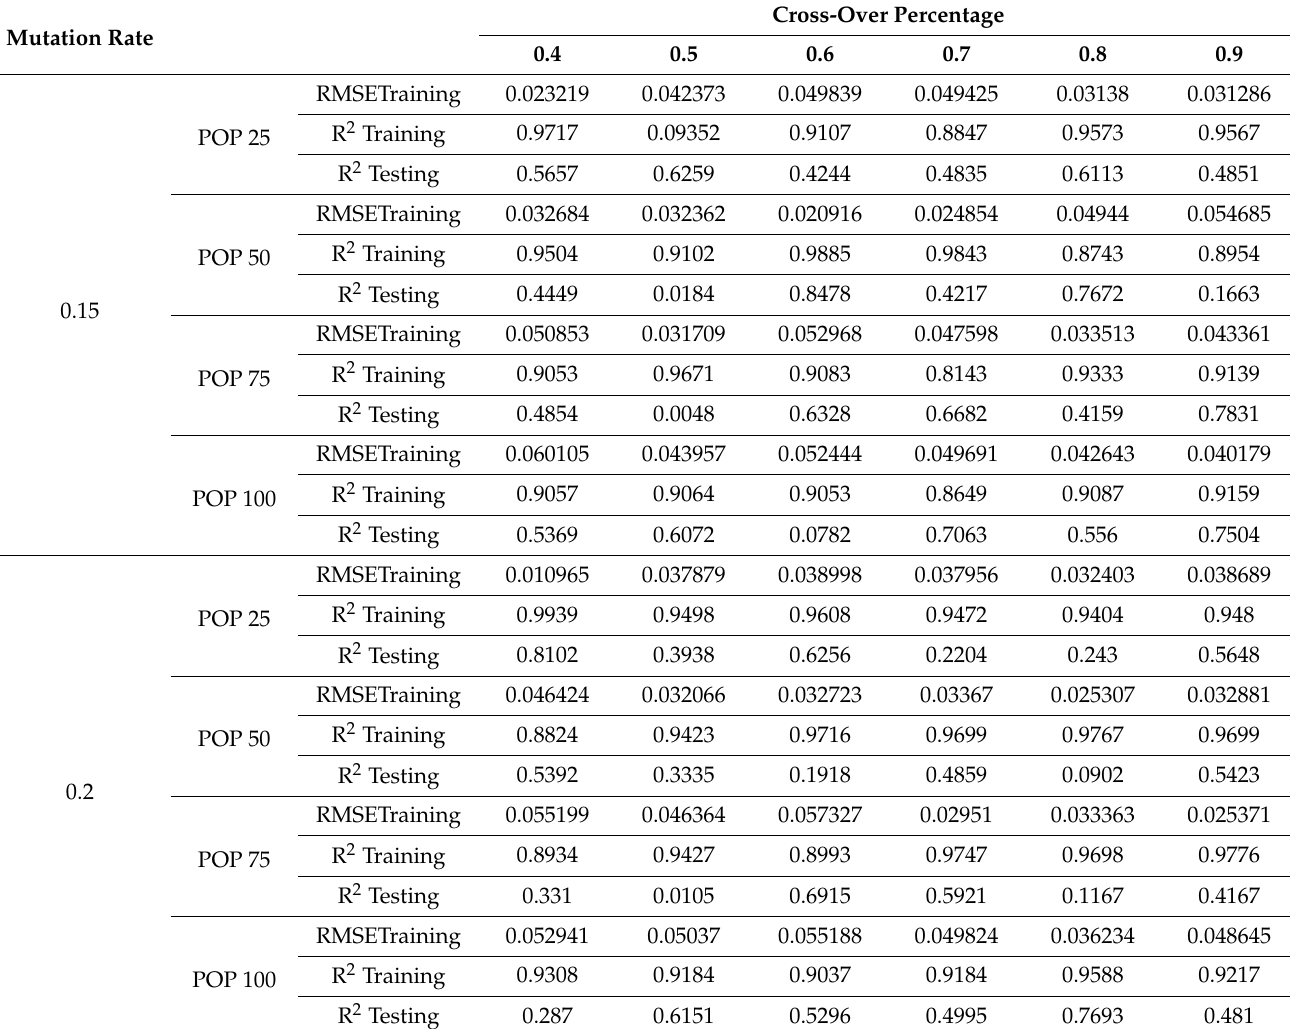
Table 8. ANFIS-GA training results.